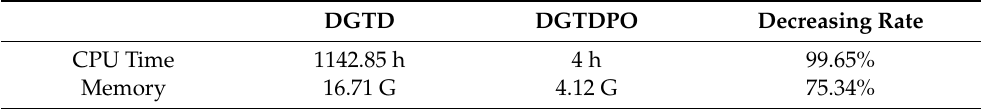
Table 7. The CPU time and memory of DGTD and DGTDPO for multi-object-rough sea surface composite Table 6. The NRMSD of DGTD, TDPO and TDSBR at 1.5GHz for multi-object-rough sea surface composite objects.